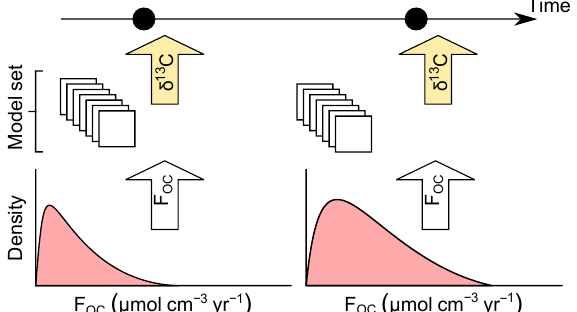
Figure 7. Schematic depiction of the work flow behind the vir- tual carbon isotope time series. Model sets consist of 50 separate reactive transport model solutions driven by a randomly selected F OC . The randomly generated organic OC flux values translate into a density distribution with a right-skewed tail. Increased F OC and a widening of the value range is used to simulate increased spatial OC heterogeneity.